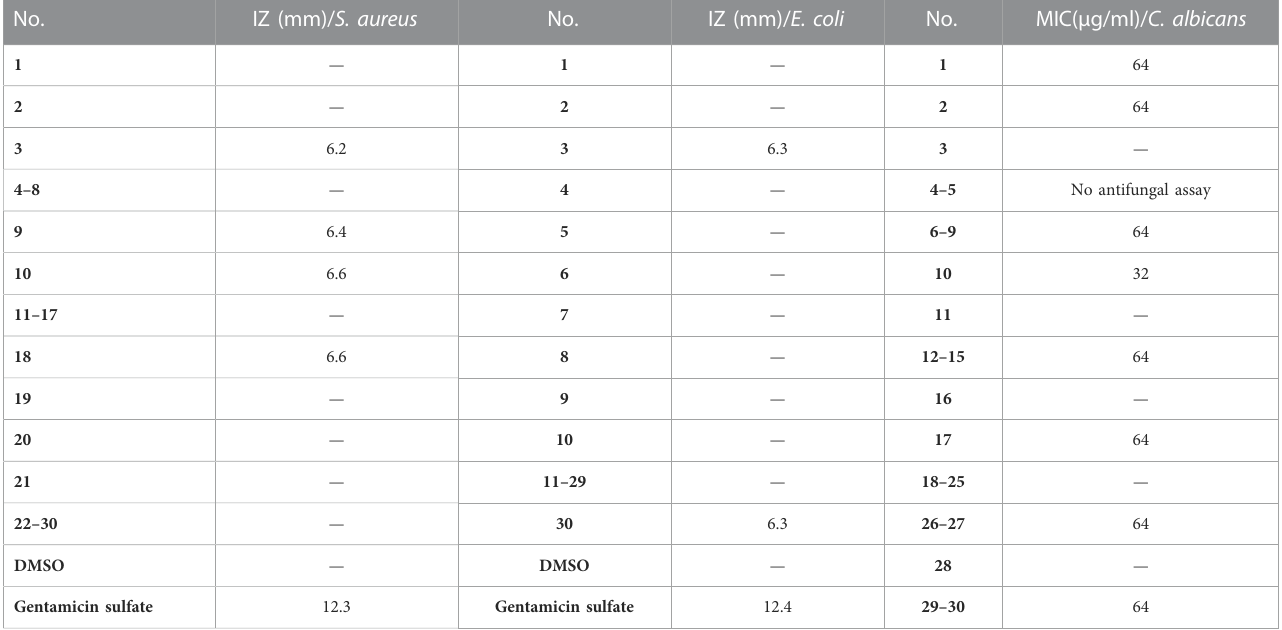
TABLE2Antimicrobialactivitiesofcompoundsfrom U.diffracta Vain.(TheIZvalueindicatedthediameteroftheinhibitionzoneat3.2 μ g/disk.TheMICvalueindicated the minimal inhibitory concentration. “—” indicated no inhibitory activity in 3.2 μ g/disk or 64 μ g/ml.) No.